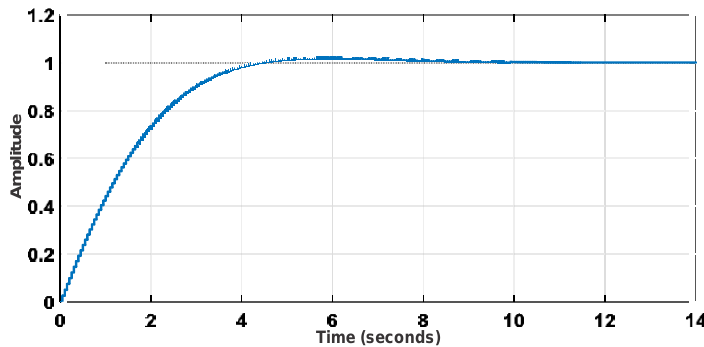
Figure 12. Step response of the closed-loop model.